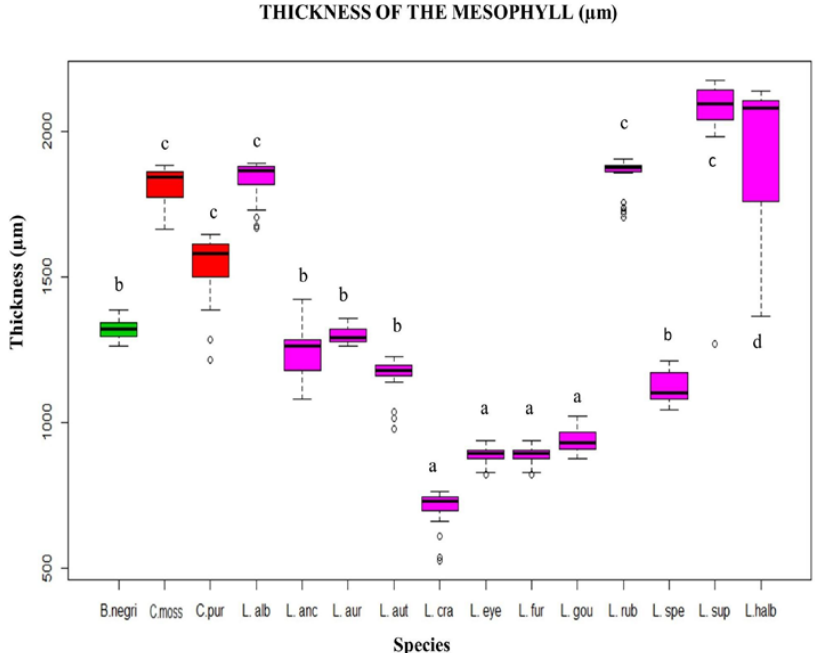
Figure 2. Box plot of mesophyll thickness evaluated by species. Each color identifies the genera: Broughtonia (green), Cattleya (red) and Laelia (pink). Each letter represents a group, according to Dunnett’s post hoc analysis. a = (500–1000 μm), b = (1001–1500 μm), c = (1501–2000 μm), d = (2001– 2500 μm).